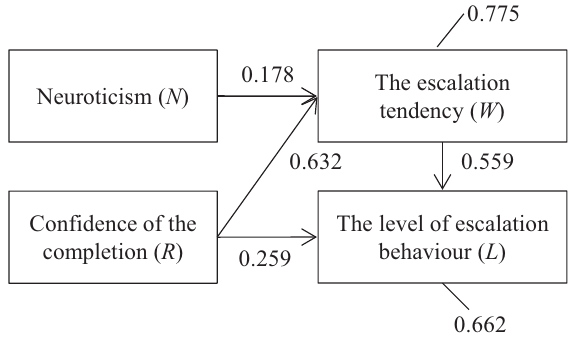
Figure 5. EOC model in Scenario